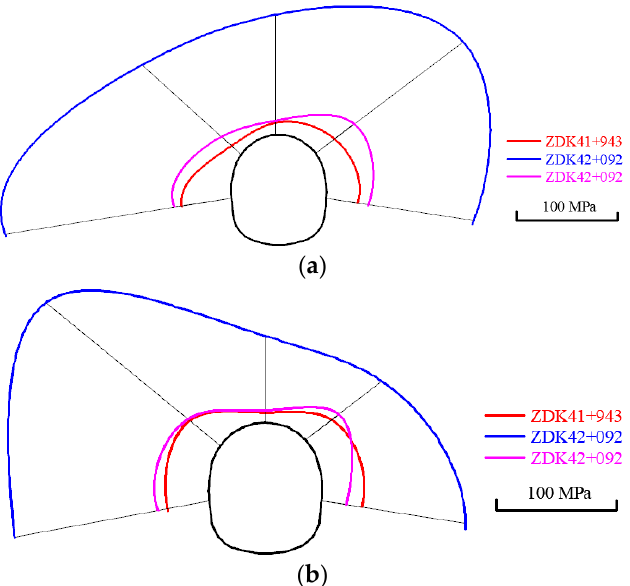
Figure 19. The reinforcement stress along the section: ( a ) reinforcement meter near the initial support side; ( b ) reinforcement meter away from the initial support side.